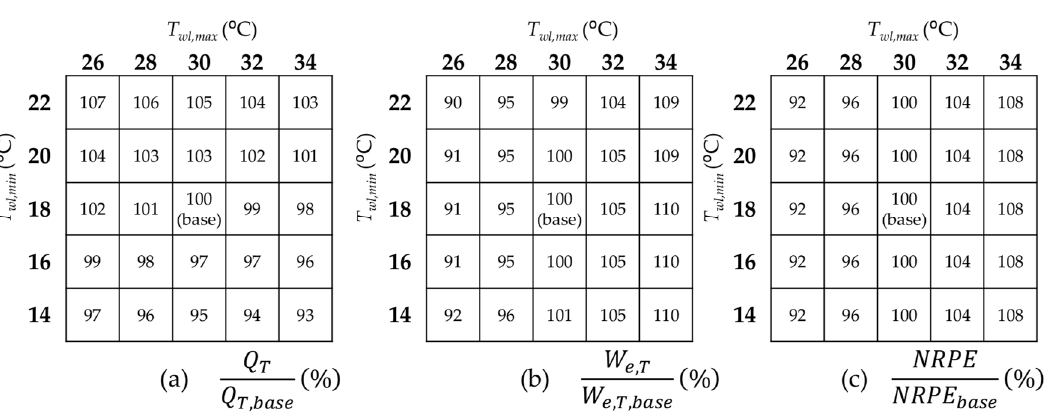
Figure 6. Effect of variations in minimum and maximum water loop set point temperatures relative to: ( a ) annual total thermal consumption; ( b ) total electrical consumption; ( c ) nonrenewable primary energy in Barcelona, with respect to a base case with 18–30 °C set point temperatures.